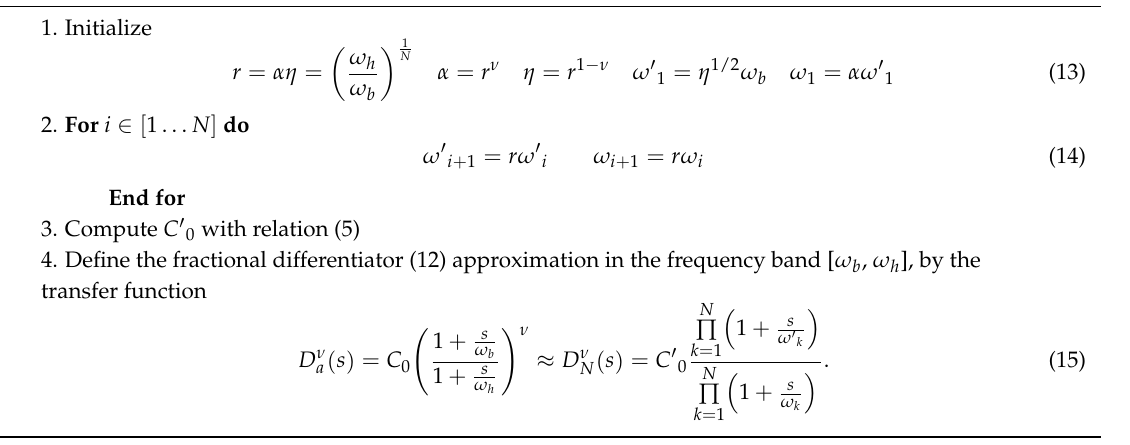
Algorithm 3. Fractional differentiator approximation—first